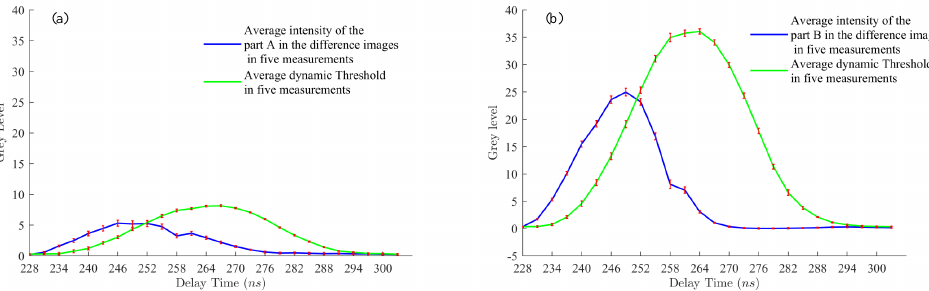
Figure 8. Averaged grey value of areas A ( a ) and B ( b ) in the intensity difference image at different delay times in five measurements. In both figures, the green curve represents the dynamic threshold used in DTAFD with ε set as